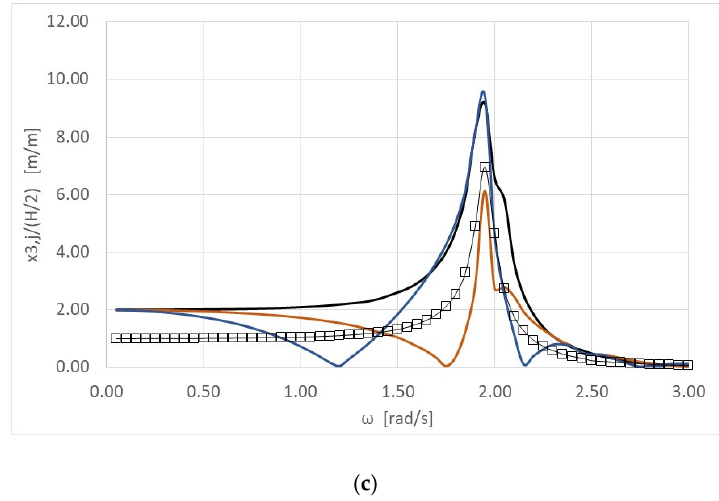
Figure 7. Dimensionless heave displacement of the 1st WEC, j = 1, of the array arranged perpendicularly to the wall, against ω , for three different examined distances from the vertical wall and three wave heading angles. Comparisons are made for the heave displacements of the same converter of the array without the presence of the breakwater: ( a ) θ = 0°; ( b ) θ = 45°; ( c ) θ = 60°.